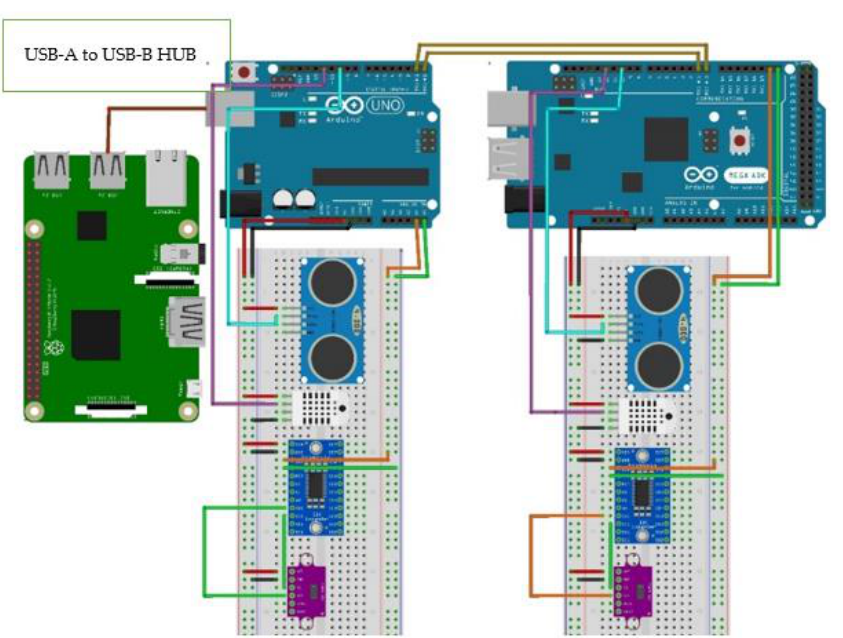
Figure 6. Scheme of the connections between the microcontrollers and the Raspberry Pi.